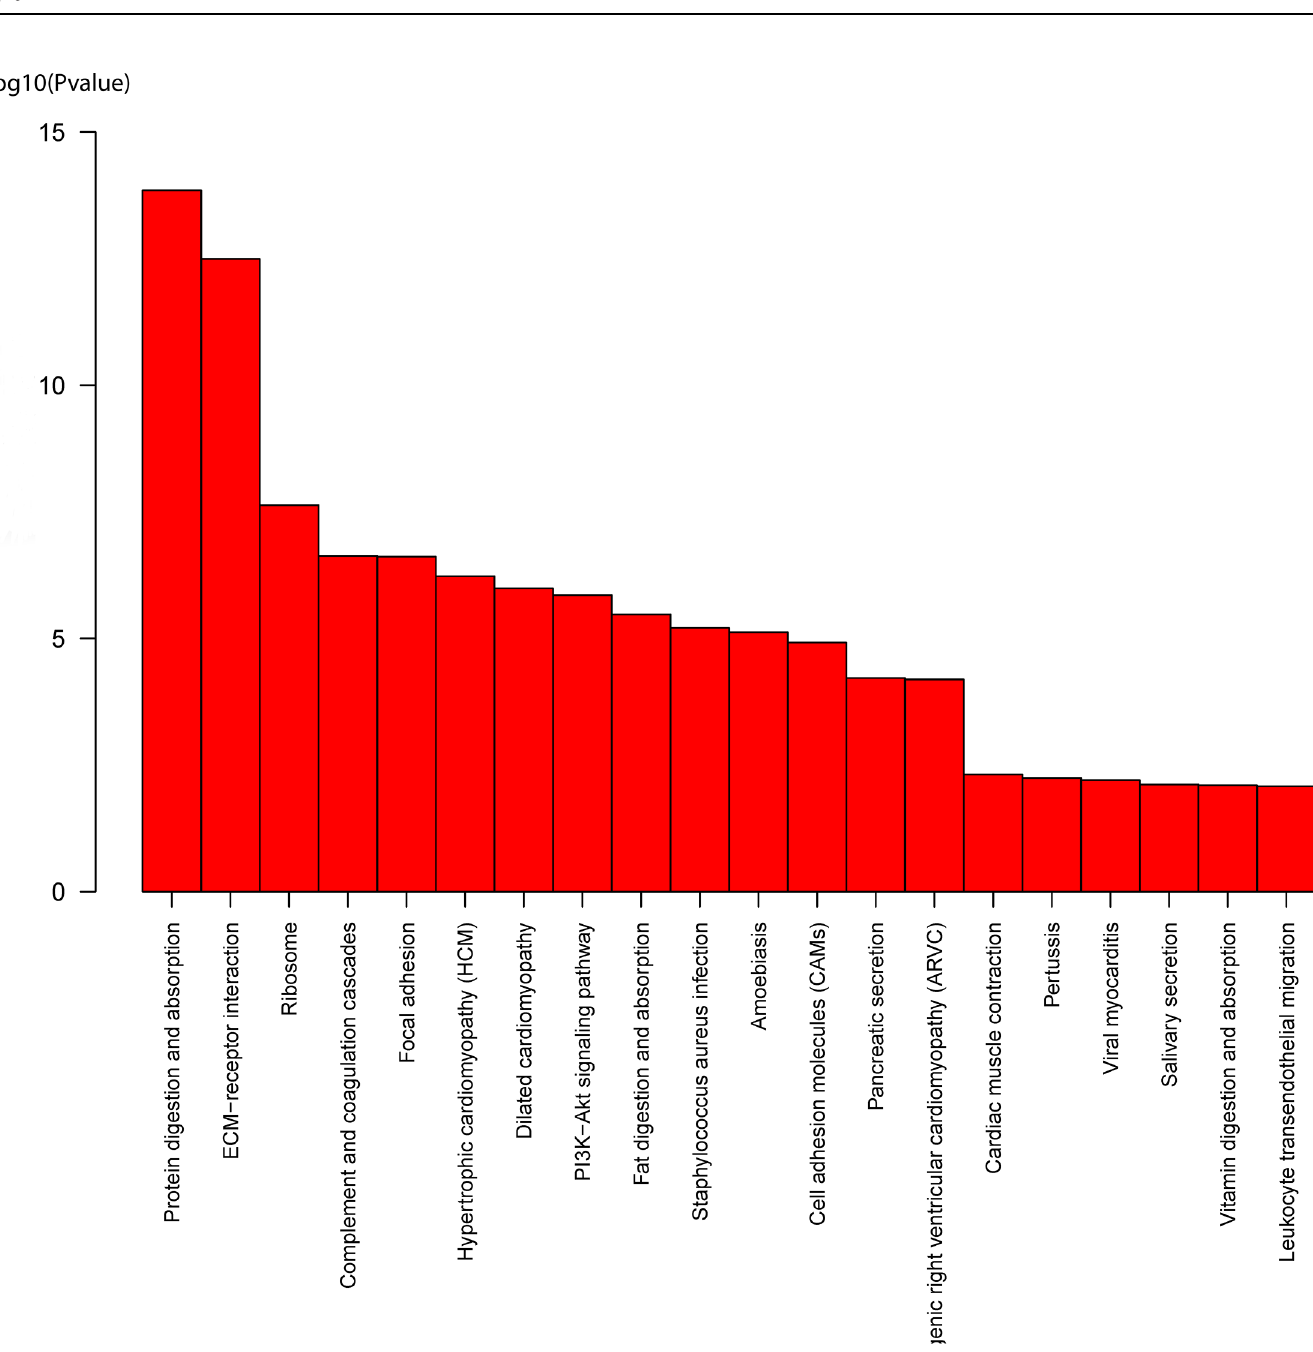
Fig 2. Histogram of the most significantly enriched KO terms obtained from the KEGG enrichment analysis of DEGs. The significance of each pathway was estimated based on the p-value (p-value < 0.05) and the FDRs (FDR (cid:5) 1.82E-01)